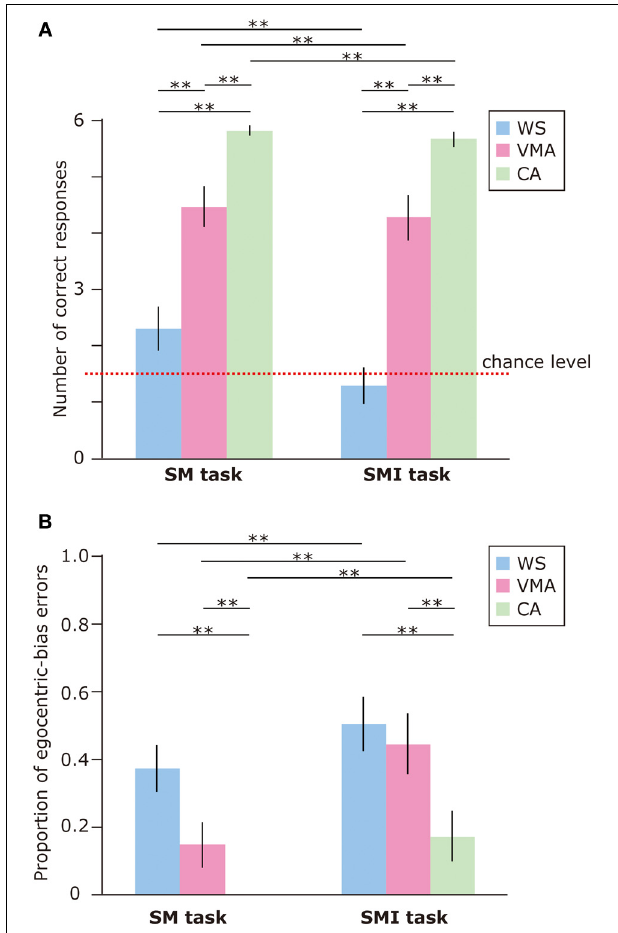
FIGURE 6 | (A) Mean number of correct trials (max: 6) in the SM and SMI tasks for three groups [blue: Williams syndrome (WS) group; pink: verbal mental age-matched (VMA) group; green: chronological age-matched (CA) group]. (B) Mean proportion of egocentric errors (the proportion of egocentric errors made in relation to the overall errors) for both tasks. Error bars indicate standard error. ∗∗ p < 0 . 01.